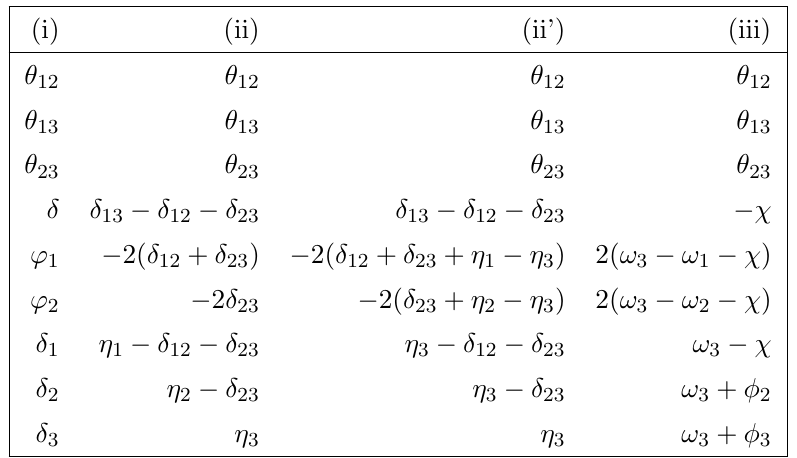
Table 4 . The parametrization stated in eq. (A.2) (i) written in terms of the parametrizations given in eq. (A.4) (ii), (A.5) (ii’) and (A.6)